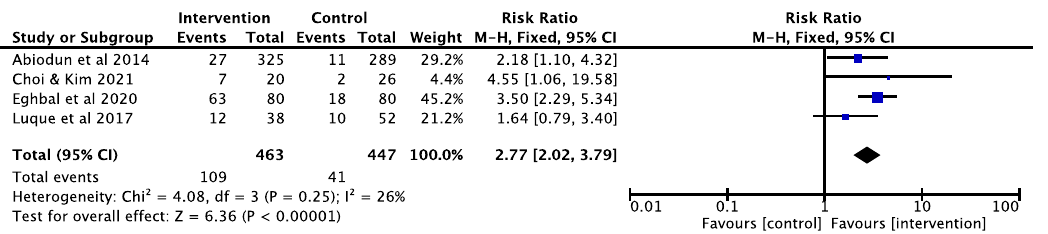
Figure 2. Effects of educational interventions on cervical cancer screening uptake (RCTs).